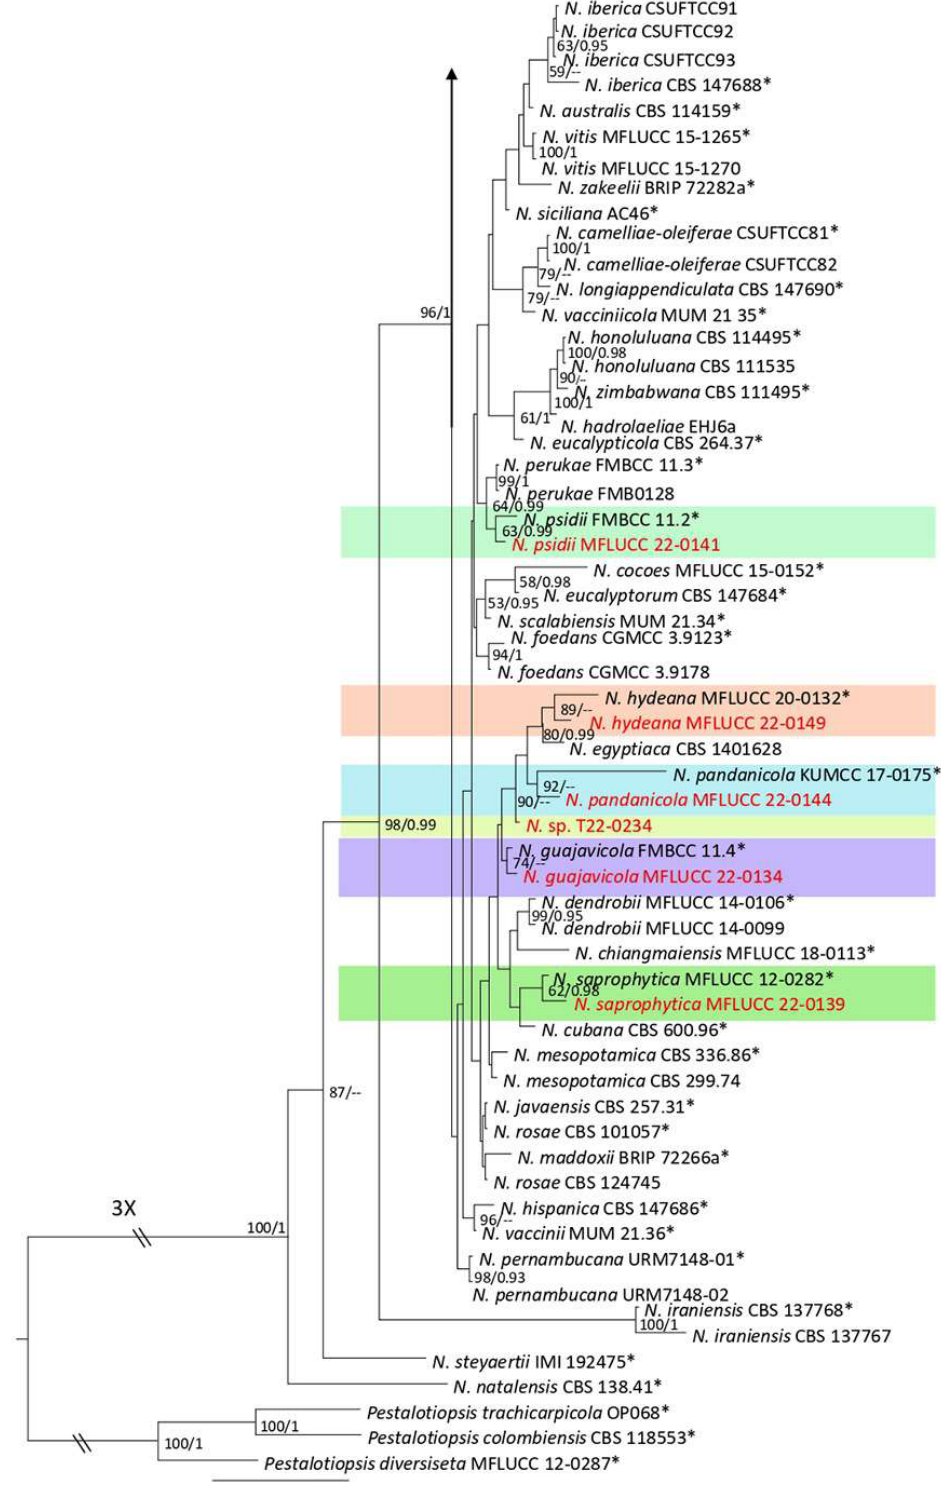
Figure 5. Bayesian phylogenetic tree of Neopestalotiopsis spp. Obtained from the combined ITS, tef1 , and tub2 sequence data. The ultrafast maximum likelihood bootstrap support (%) ≥ 50 and BYPP ≥ 0.95 are shown at the nodes. The ex-type strains are marked with an asterisk. The tree is rooted in Pestalotiopsis trachicarpicola (OP068), P. colombiensis (CBS 118553), and P. diversiseta (MFLUCC 12 - 0287 ).